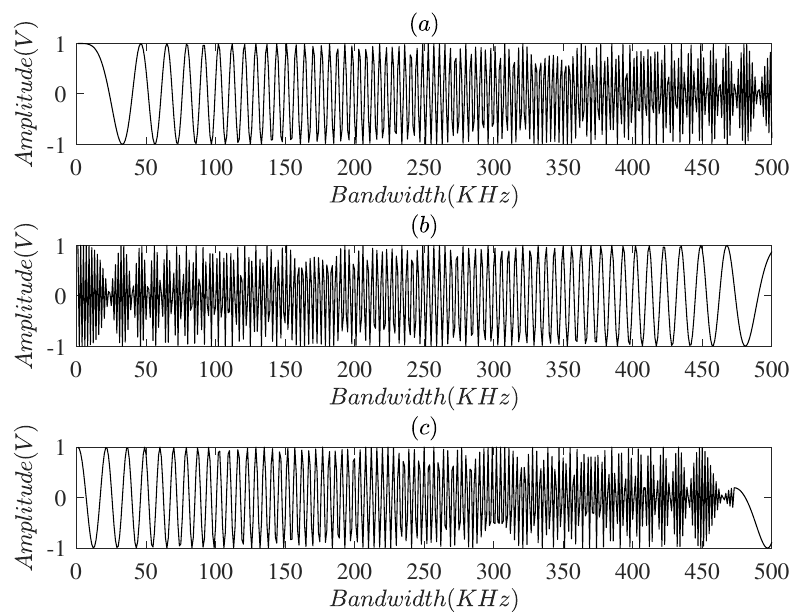
Figure 5. ( a ) up-chirp, ( b ) down-chirp, and ( c ) coded LoRa signal with SF = 8 and BW = 500 kHz.